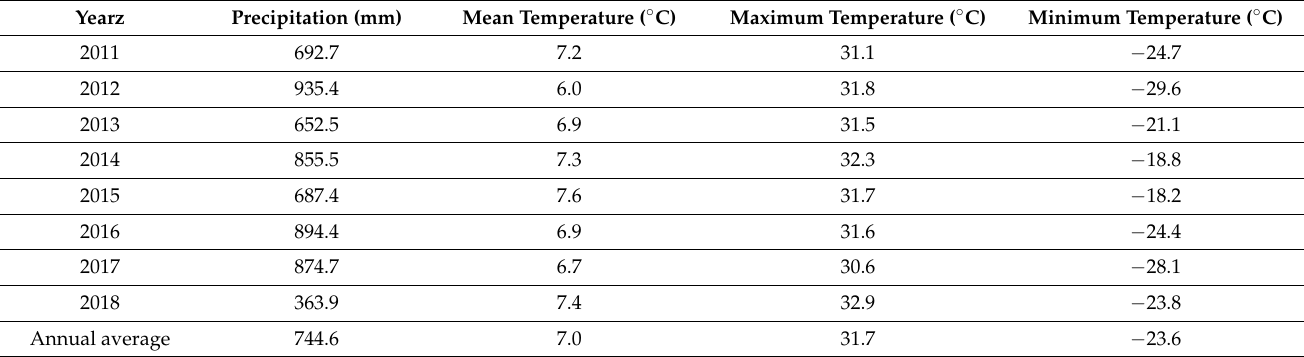
Table A1. Average climatic conditions of the study site located in Latvia during the study period.